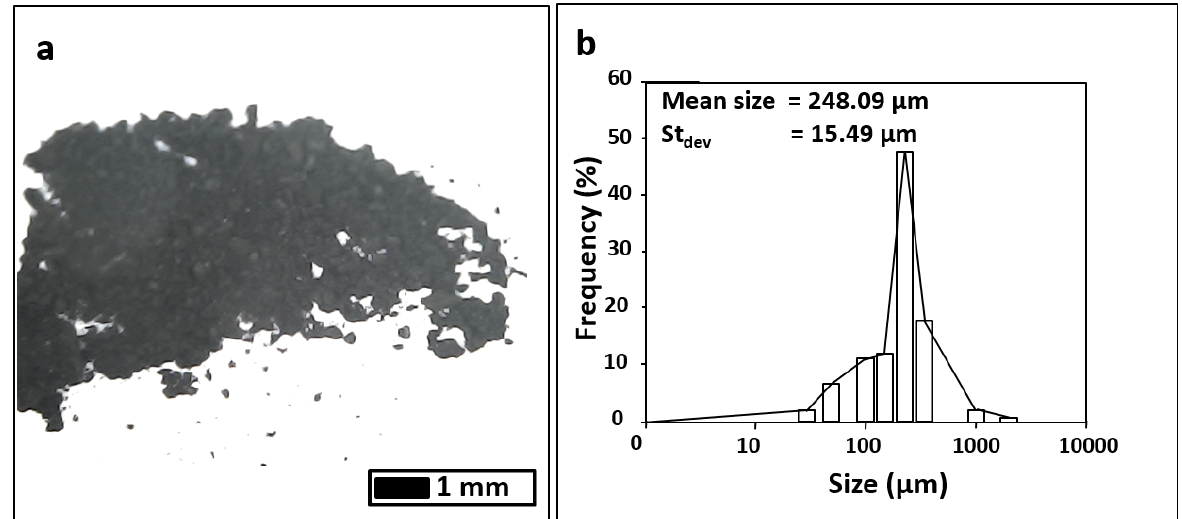
Fig. 3. Photograph image of carbon particles (a) and their particle size distribution (b).